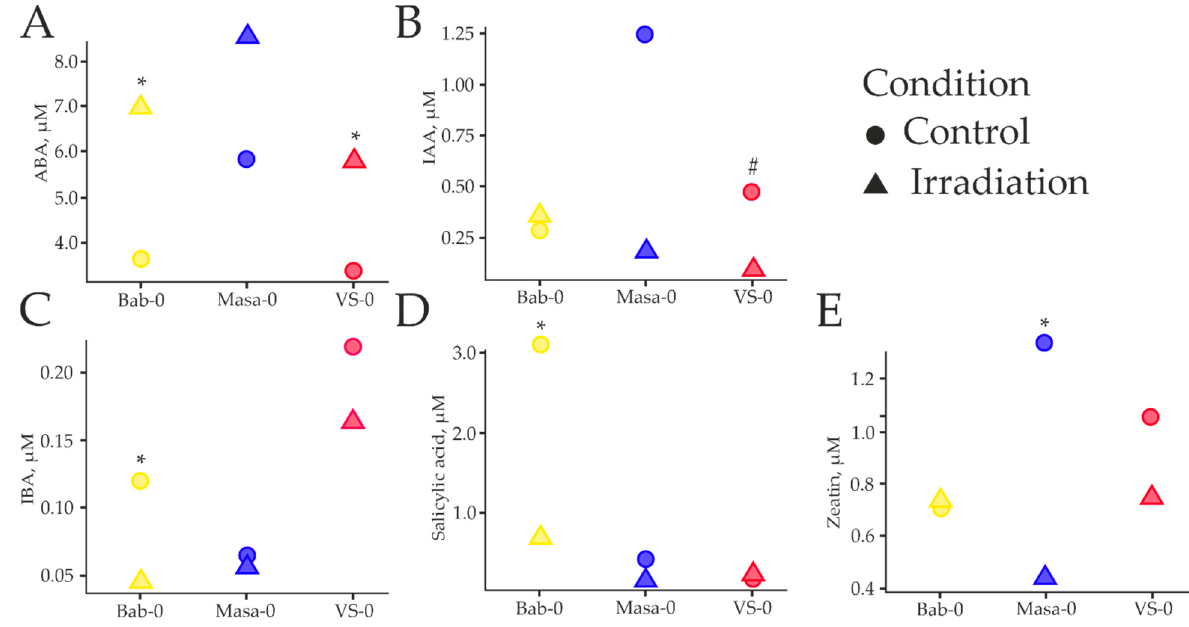
Figure 6. Median values of concentrations of five phytohormones (ABA—abscisic acid ( A ); IAA— indole-3-acetic acid ( B ); IBA—indole-3-butyric acid ( C ); salicylic acid ( D ); zeatin ( E )) measured on 17th day in plants grown from seeds of Bab-0, VS-0, and Masa-0 accessions. Dots—control plants grown from seeds collected from the experimental plots with background or low-dose chronic irradiation and not exposed to acute γ -irradiation; triangles—plants grown from seeds exposed to acute γ -irradiation at a dose of 150 Gy. Phytohormones were measured in two technical replicates of 2–4 biological replicates composed by a pool of 10 plants each. Significant differences (Mann–Whitney U -test) between non-treated and acutely irradiated plants are denoted by * p < 0.050; # p = 0.052. The graphs were created using RStudio v1.4 (R-Tools Technology, Richmond Hill, ON, Canada).